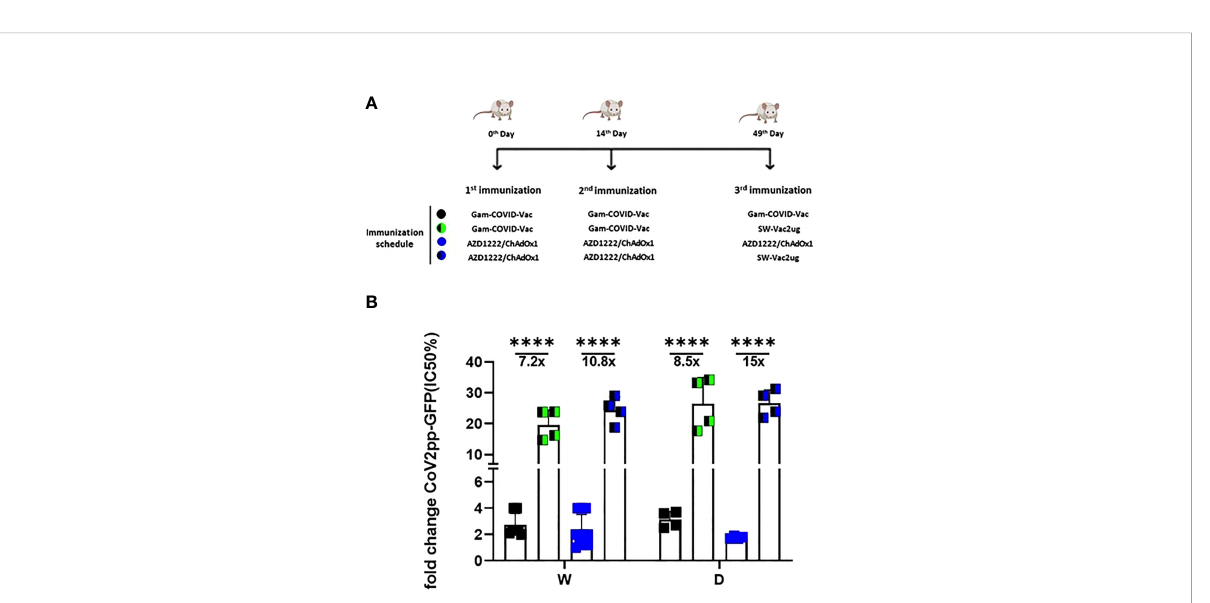
FIGURE 7 Neutralizing capacity against W or D pseudovirus induced by a booster with SW-Vac 2µg formulation. BALB/c mice were immunized on Days 0 and 14 with commercial Gam-COVID-Vac-rAd26/rAd5 or AZD1222/ChAdOx1 vaccine plus a booster with SW-Vac formulation, Gam-COVID- Vac-rAd5 or AZD1222/ChAdOx1 on Day 49 delivered intramuscularly (A) . Serum was collected on Day 14 after the last dose. Neutralizing titers were measured by 50% inhibition for the pseudotyped virus (CoV2pp-GFP) in immunized and non-immunized mice (B) . Absolute inhibitory concentration was calculated as the corresponding point between the 0% and 100% assay controls. Fifty % inhibition was de fi ned by the controls for all the samples on the same plate. Data is presented as the fold change of CoV2pp-GFP related to the minimum value detected in immunized animals. For statistical analysis, one-way ANOVA with Bonferroni`s multiple comparisons test was used.